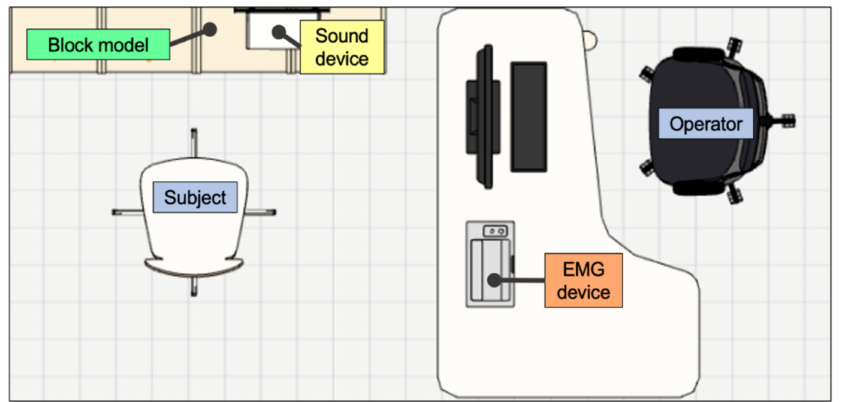
Figure 7. Experimental environment and equipment arrangement.